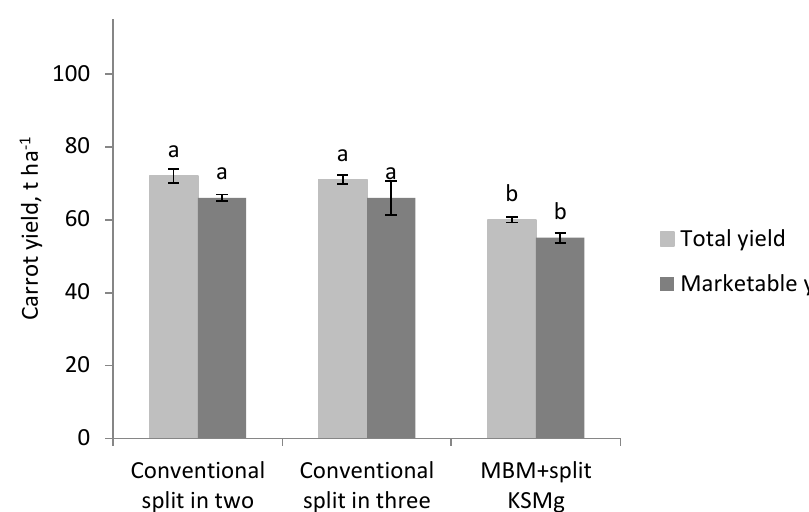
Fig. 4. Total root yield and marketable root yield of carrot by different fertilizations in 2011. (Error bars:± standard error. Different lowercase letters above columns indicate significant ( p =0,05) differences between the means.)